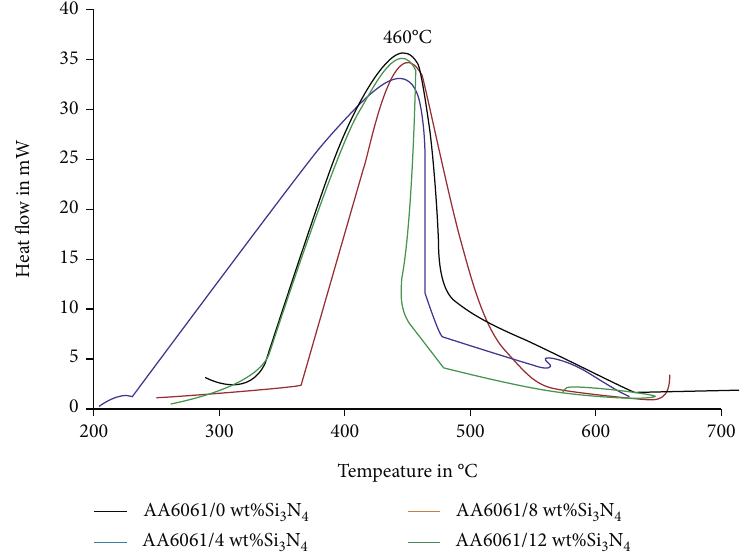
Figure 6: Heat fl ow analysis of AA6061/Si